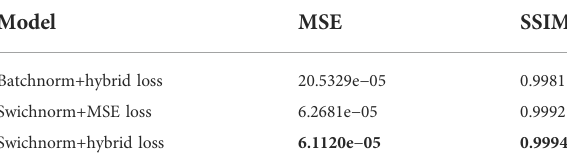
TABLE 3 Ablation experiment on SEG C3 synthetic data (the bold font indicates the best value).